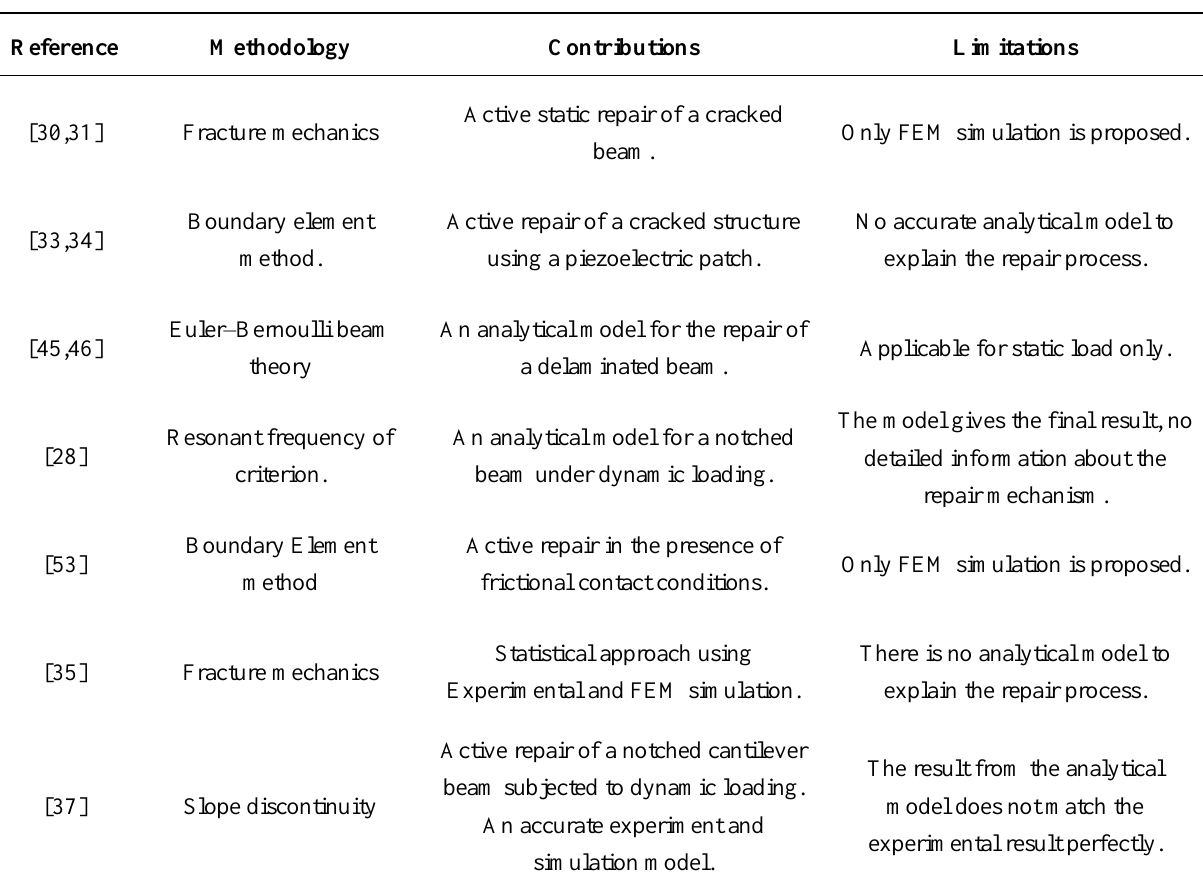
Table 1. Key aspects of different methodologies used for active repair and control using piezoelectric